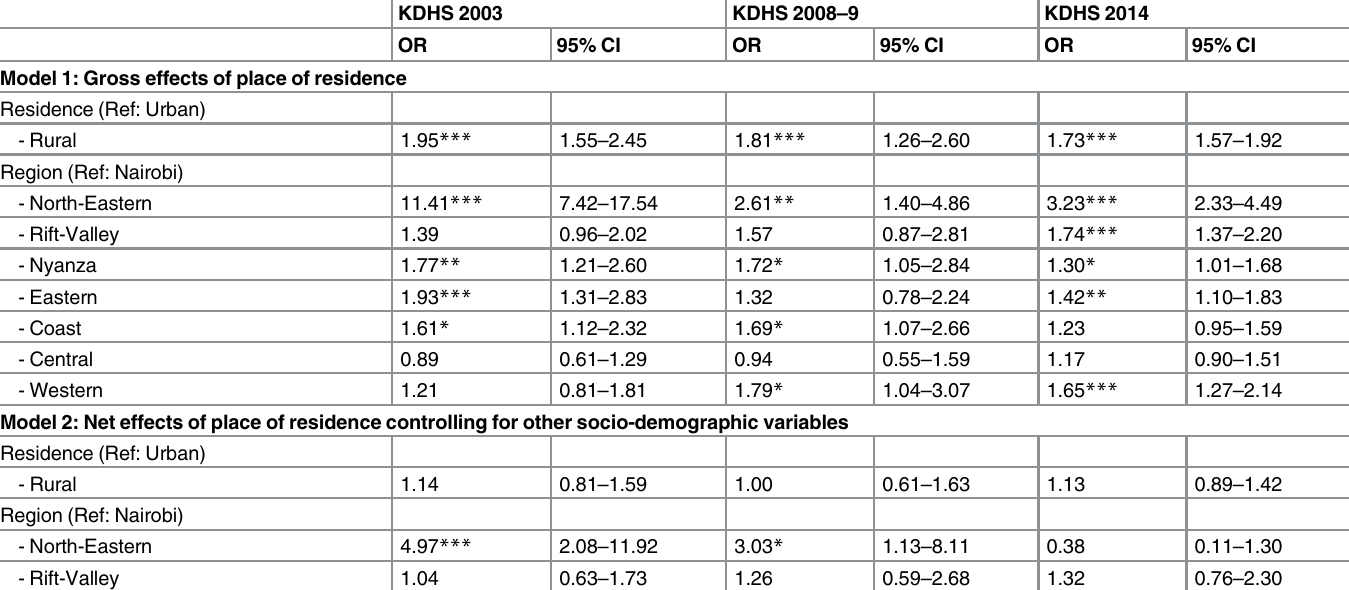
Table 4. Correlates of antenatal visits ( (cid:3)